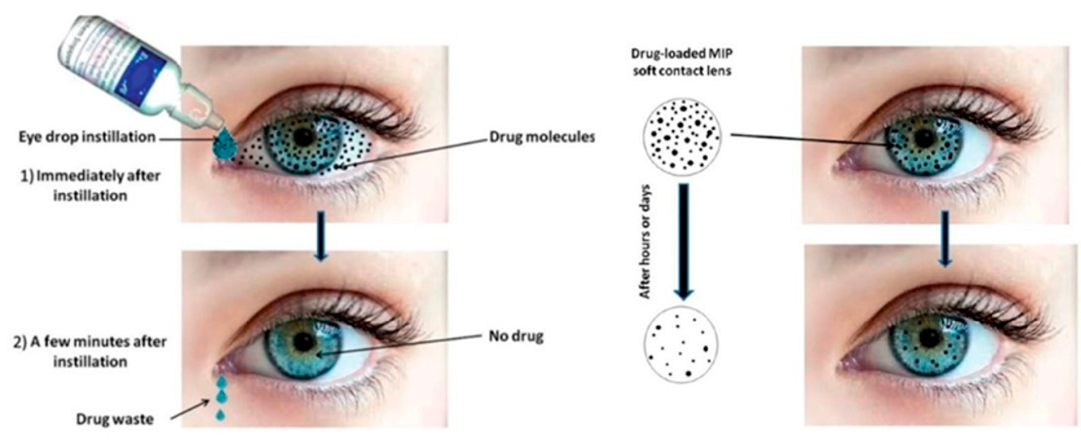
Figure 2. The superiority of soft drug loaded contact lenses in comparison to eye drops. Adapted with permission from [12], J. Pharmacol. Exp. Ther., 2019.